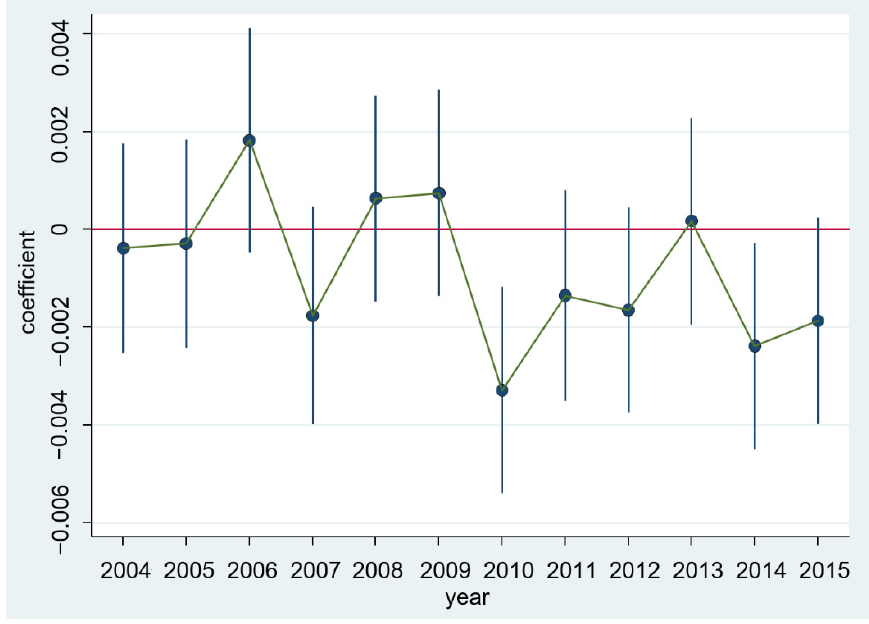
Figure 2. Parallel trend test of GAD index. Table 5. Considering time trend, municipalities, concurrent events, and climatic